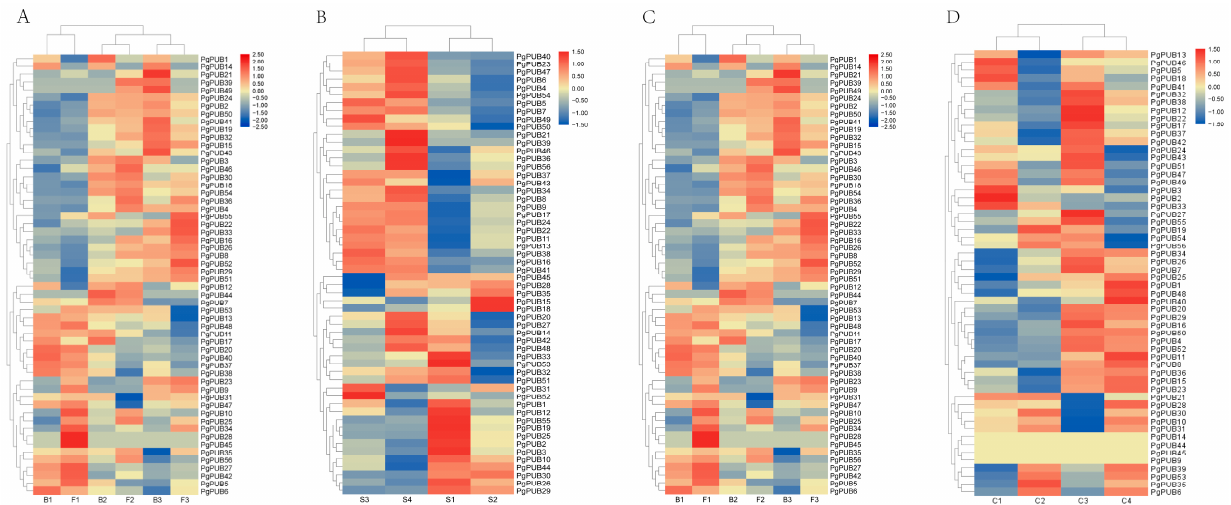
Figure 5. Expression profiles of pomegranate U-box genes in 20 transcriptome libraries. ( A ) Heatmap of PgPUBs in the pistil with different stages of flower development. ( B ) Heatmap of PgPUBs in four seed germination stages. ( C ) Heatmap of PgPUBs in the leaf and root under salt stress. ( D ) Heatmap of PgPUBs in fruits exposed to LTC (low-temperature conditioning) and cold storage.